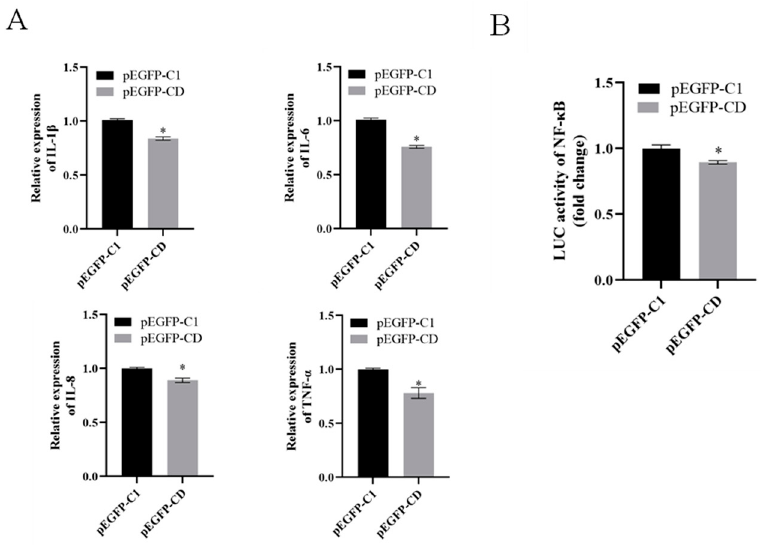
Figure 7. Ec-CD overexpression inhibited the pro-inflammatory signaling molecules. ( A ) GS cells were transfected with pEGFP-C1 or pEGFP-CD for 24 h, followed by the transcription of IL-1 β , IL-6, IL-8 and TNF- α , which were analyzed by qRT-PCR. ( B ) GS cells were co-transfected with NF- κ B-Luc and pEGFP-C1 or pEGFP-CD for 24 h, and then the activities of NF- κ B promoters were detected. Data are means ± SD from four experiments. Student’s t -test: * p < 0.05.